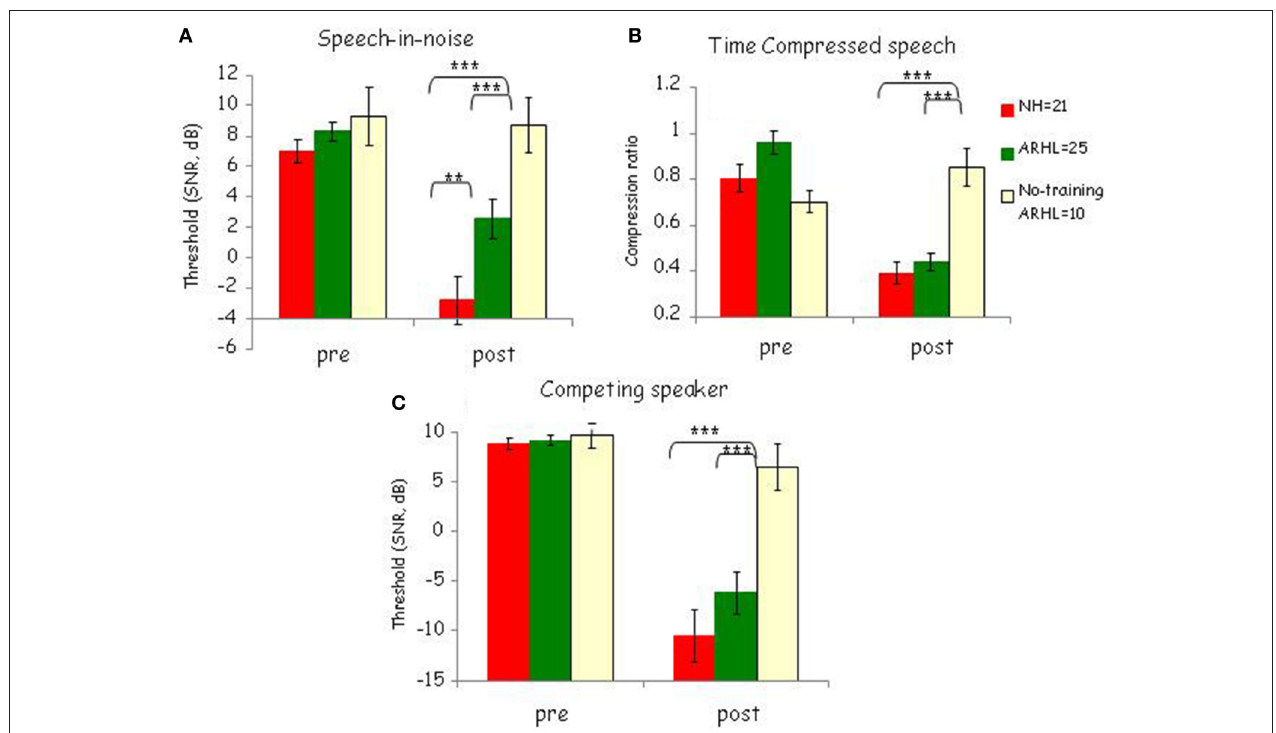
FIGURE 4 | Pre-to-post learning effects. Pre- and post-test performance in trained normal-hearing [NH, trained ARHL (ARHL)] and no-training ARHL group for the three conditions: (A) Speech-in-noise (B) Time-compressed speech and (C) competing speaker. Mean signal-to-noise ratio (SNR) thresholds and SDs are shown for the speech-in-noise and competing speaker conditions and mean compression ratio thresholds and SDs are shown for the time-compressed speech condition. *** p < 0.001 ; ** p < 0.01 .